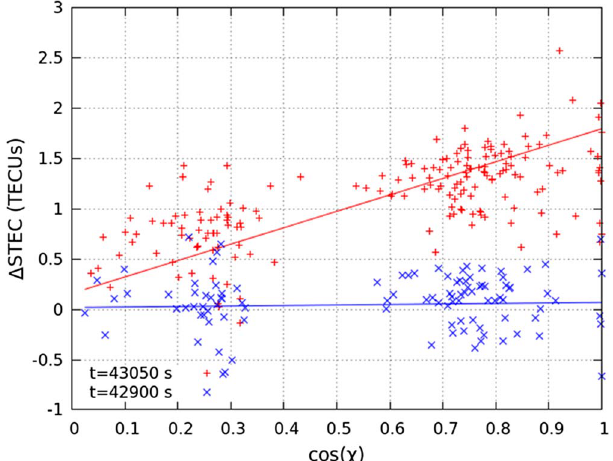
Fig. 4. D STEC (blue line) detects the moment when the ionizing radiation (red line) has a sudden increase caused by the SF on September 6,